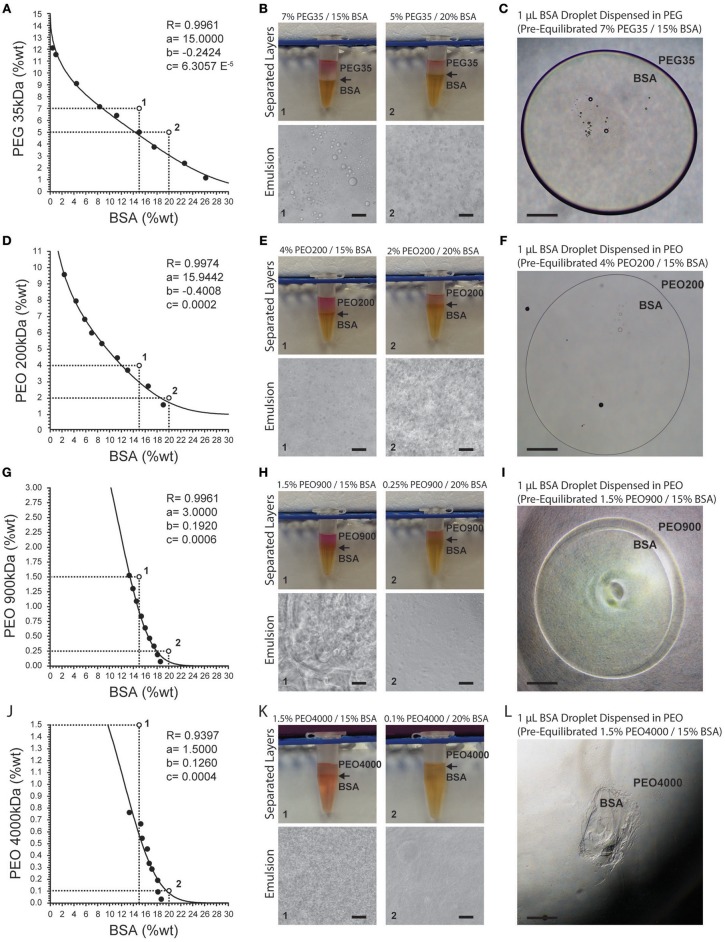
Binodal curves for PEG- and PEO-BSA systems. (A) PEG 35 kDa-BSA, (D) PEO 200 kDA-BSA, (G) PEO 900 kDa-BSA and (J) PEO 4000 kDa-BSA. R is the correlation coefficient. Fitting parameters are denoted by a, b, and c. Points 1 and 2 correspond to formulations shown in images to the right. (B,E,H,K) show macroscopic and microscopic images of PEG, PEO, and BSA at different concentrations indicated by numbered points on the binodal graphs. Arrows indicate the location of the interface between the phases. (C,F,I,L) show microscopic images of pre-equilibrated BSA droplets dispensed in pre-equilibrated PEG and PEO solutions. Scale bars in (B,E,H,K) are 50 μm. Scale bars in (C,F,I,L) are 500 μm.